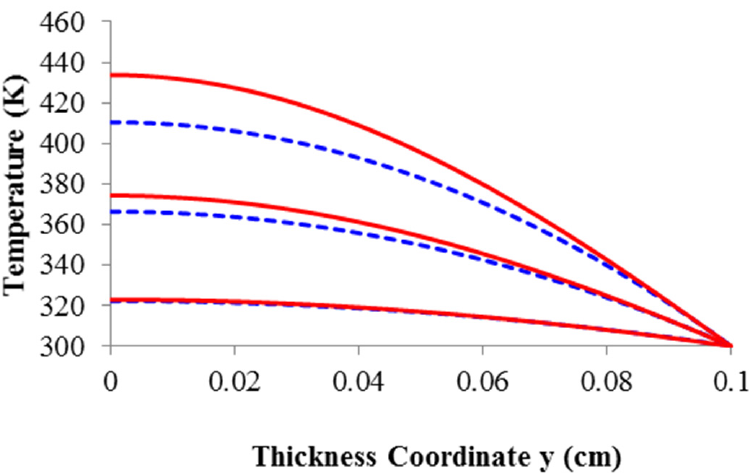
Figure 1. Temperature as a function of thickness coordinate y , for the standard model (blue) and the new model described here, for heat density values of 500, 1500, and 2500 W/cm 3 (bottom to top) and an ambient cooling temperature of 300 K. Appl. Sci. 2016 , 6 , 23